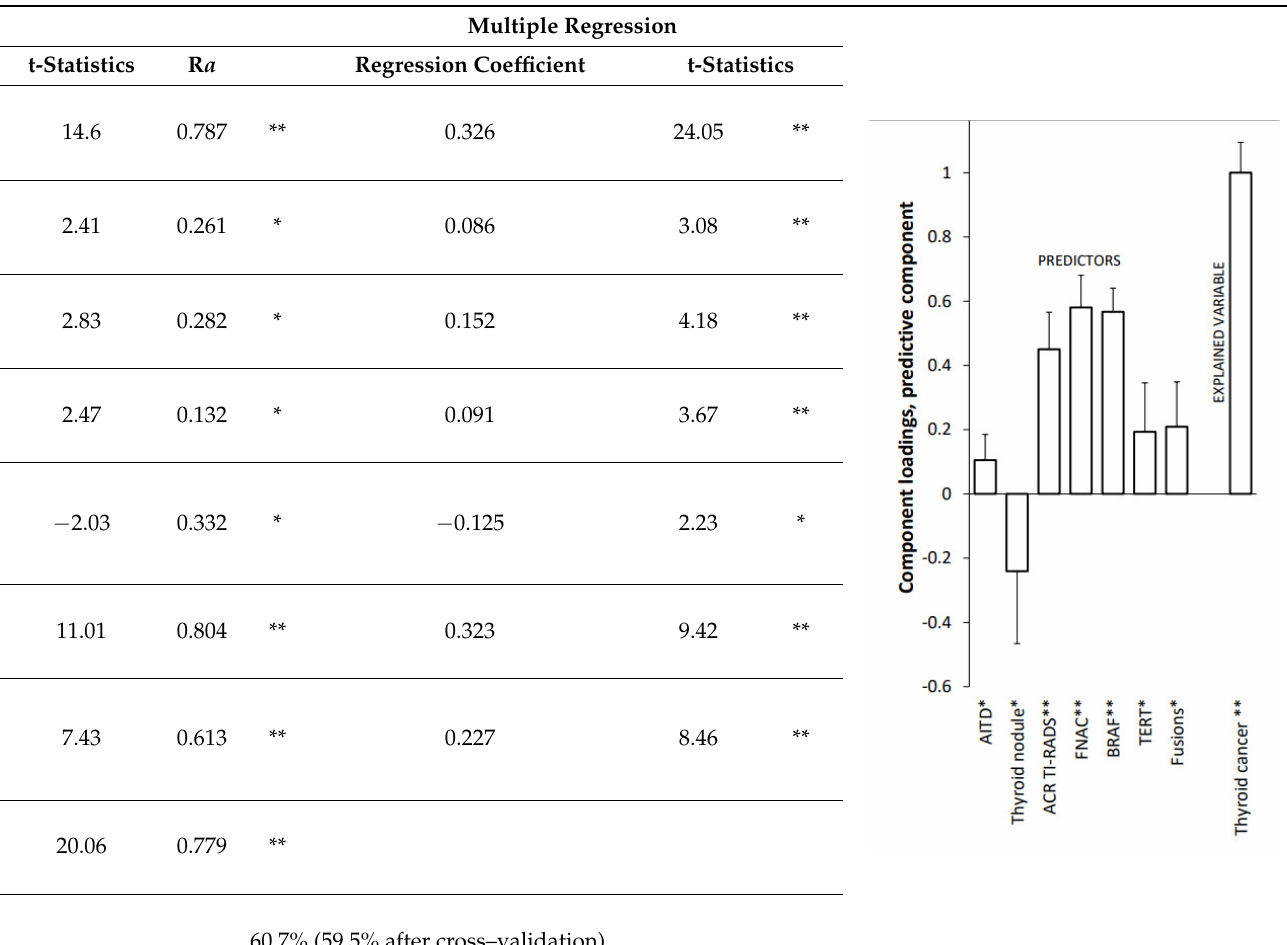
Table 2. Relationships between the cohort of patients with thyroid cancer (M) and predictors for the 1st predictive component as evaluated by the O2PLS model and multiple regression (for details, see statistical analysis). Ra-component loadings are expressed as correlation coefficients with predictive components. * p < 0.05; ** p